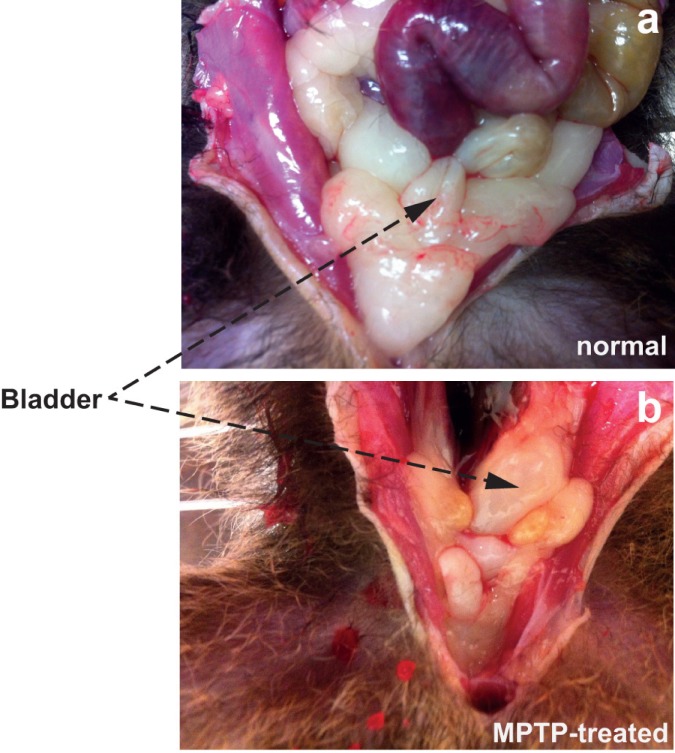
In situ localisation of normal (a) and MPTP-treated bladder in the hypogastric region of the common marmoset. Invariably, the bladder of the MPTP-treated common marmosets were larger in size.